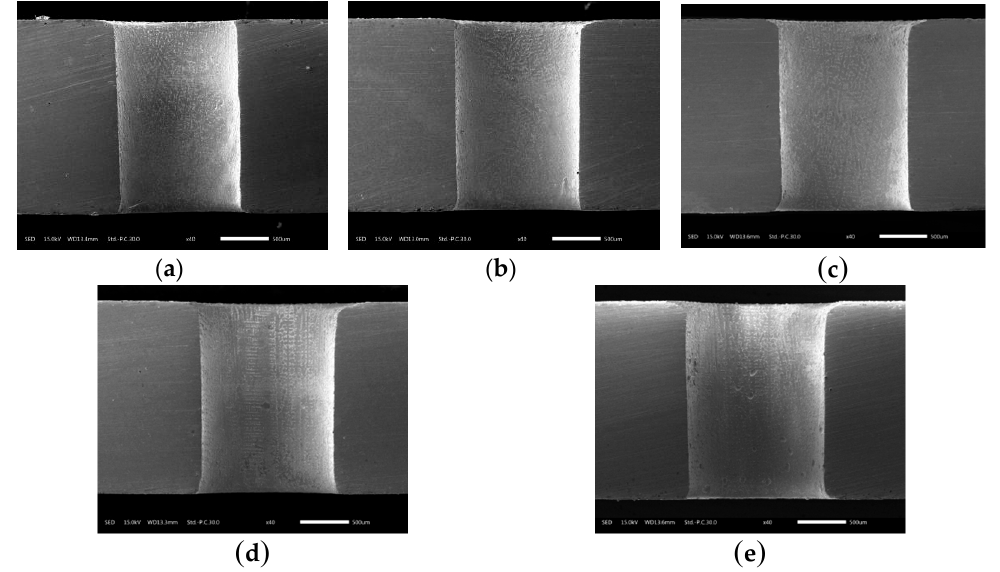
Figure 22. Sectional views of holes after electrochemical reaming for different durations: ( a ) 5 s; ( b ) 10 s; ( c ) 15 s; ( d ) 20 s; ( e ) 25 s.